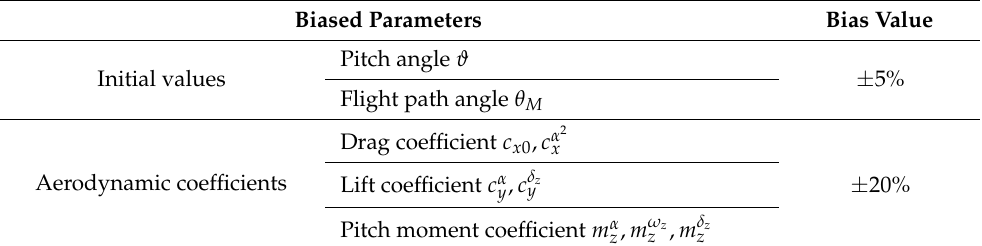
Table 5. Biased parameters.